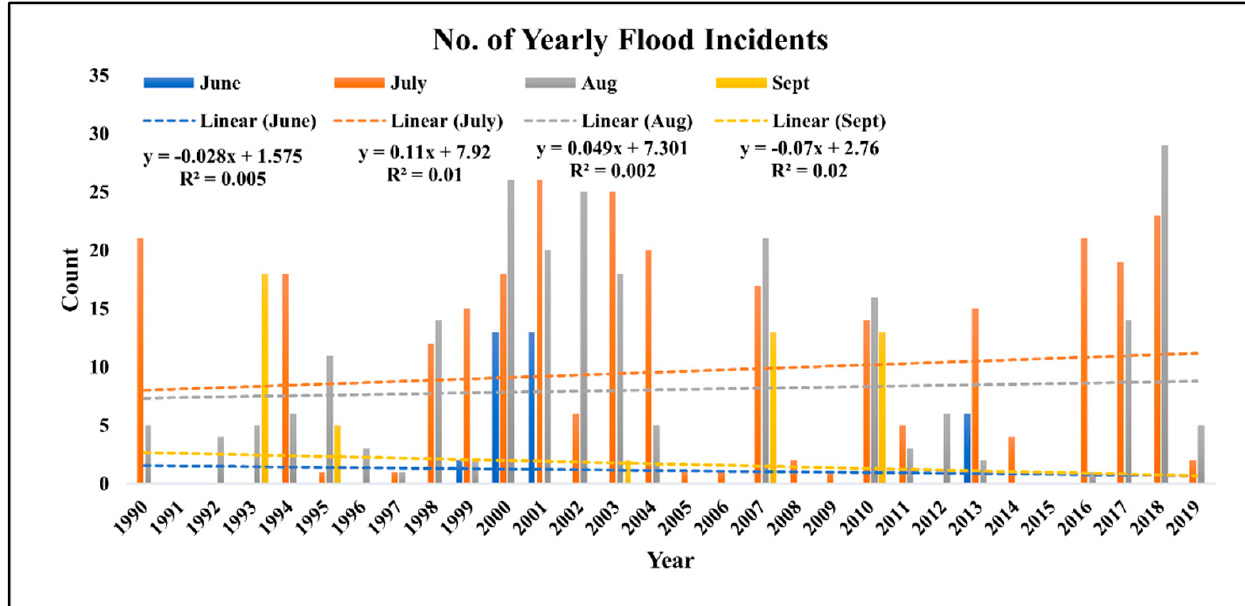
Figure 7. The time series of the number of flood incidents.